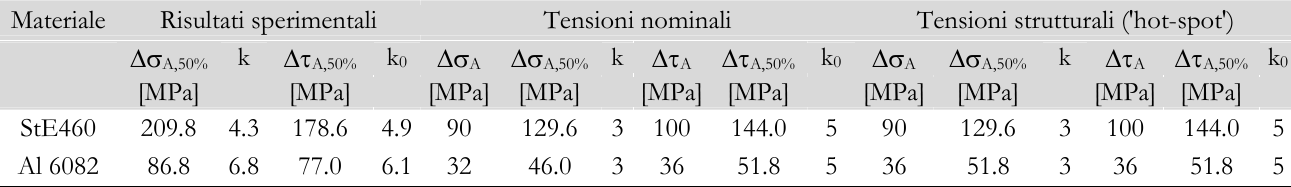
Tabella 1: Curve a flessione e torsione utilizzate per calibrare il metodo delle CWM.